Question: Looking at the figure, what chart type is it?
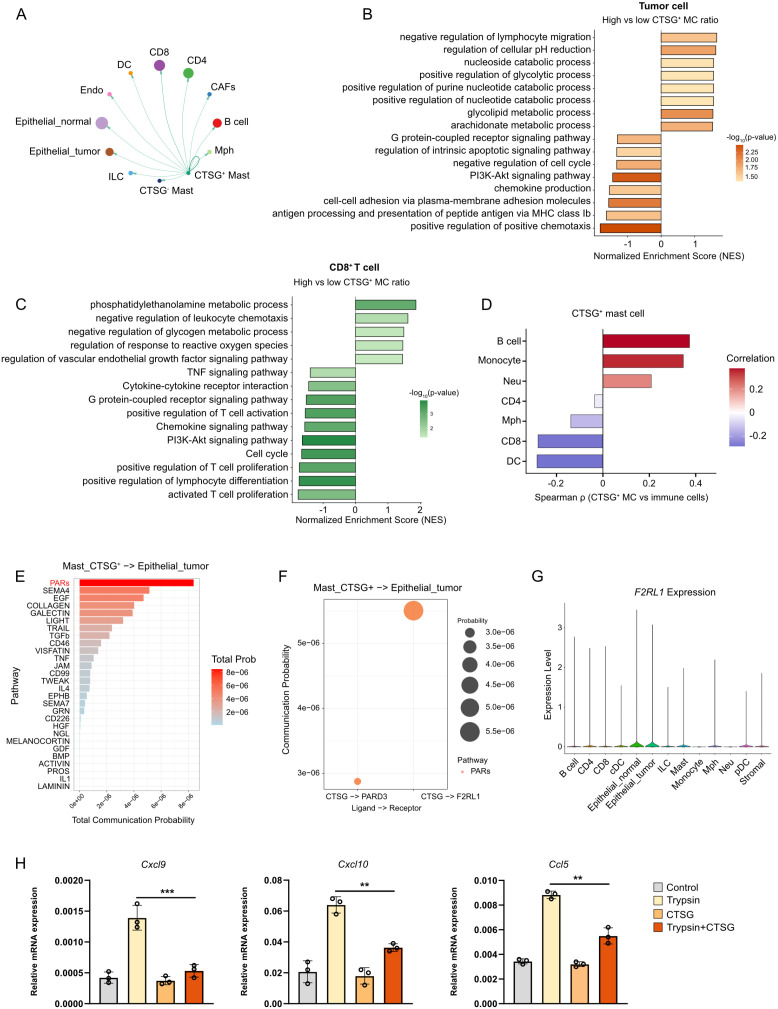
Answer: bar